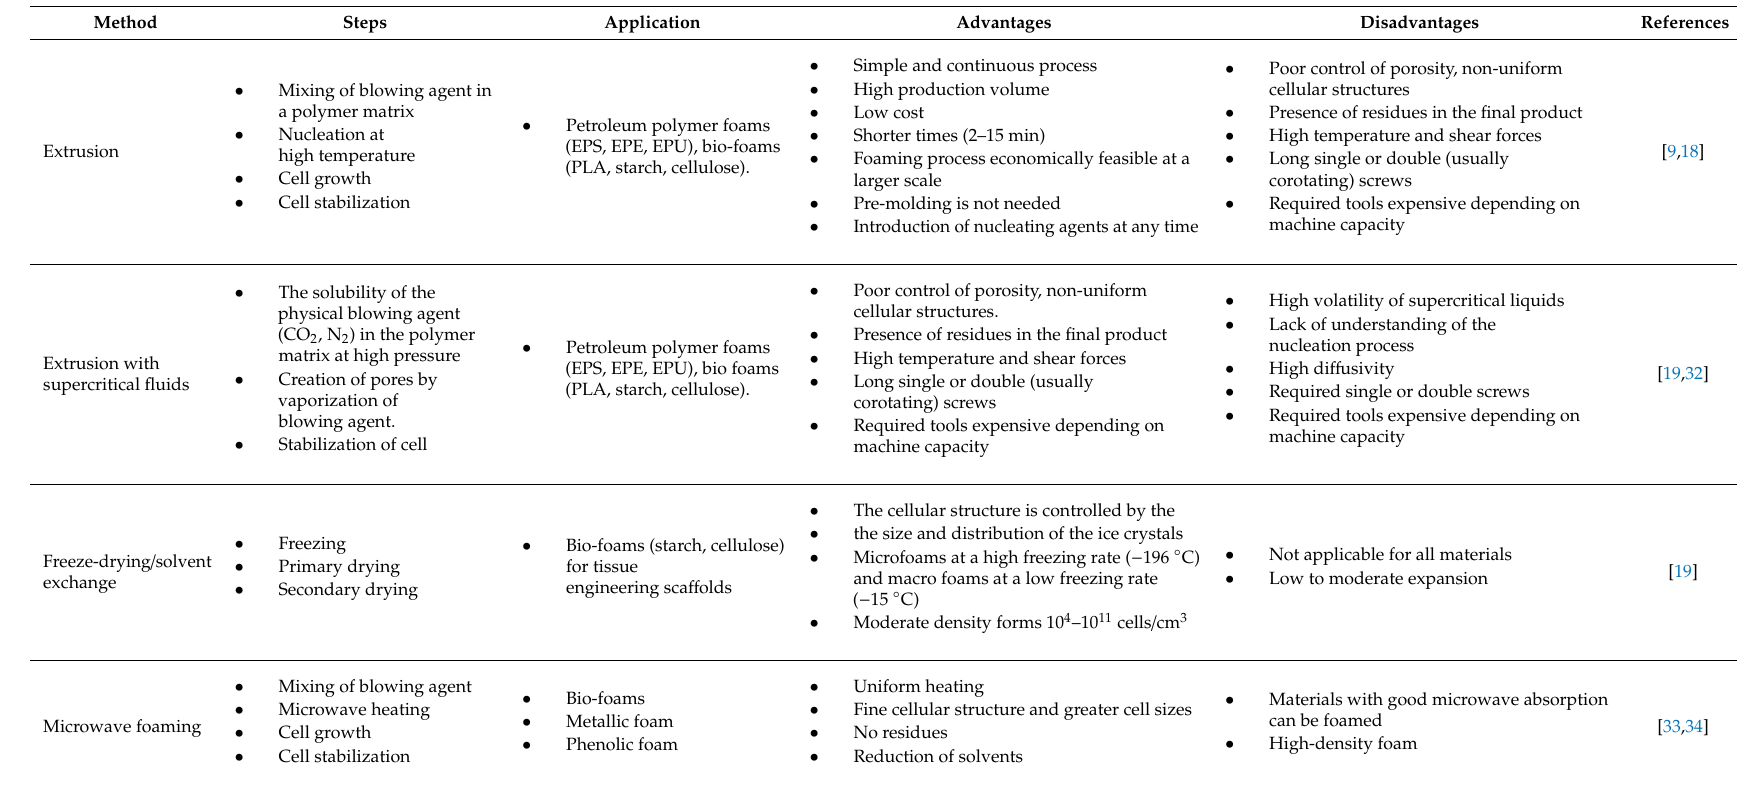
Table 1. A brief summary of methods used for the foaming of